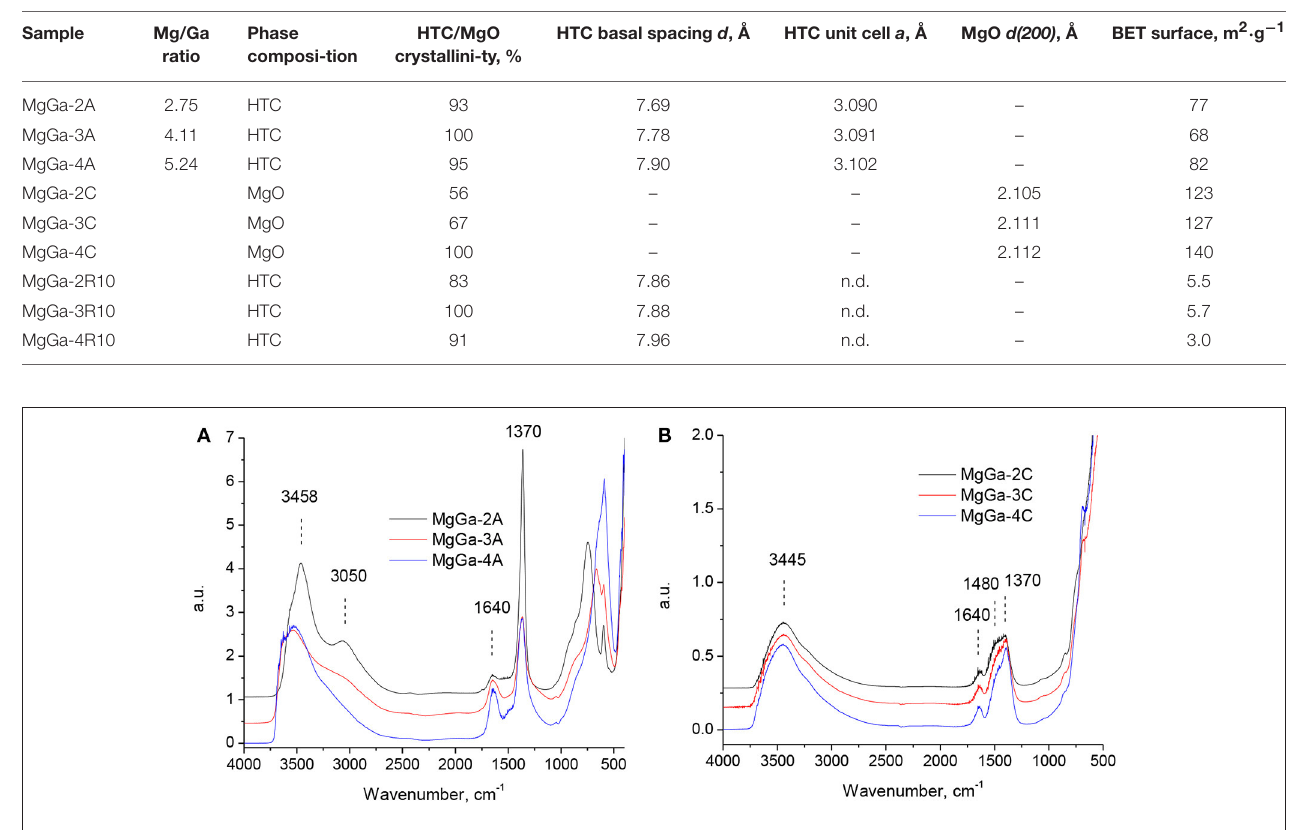
FIGURE 2 | DRIFT spectra of as-prepared MgGa LDHs (A) and MgGa mixed oxides (B)